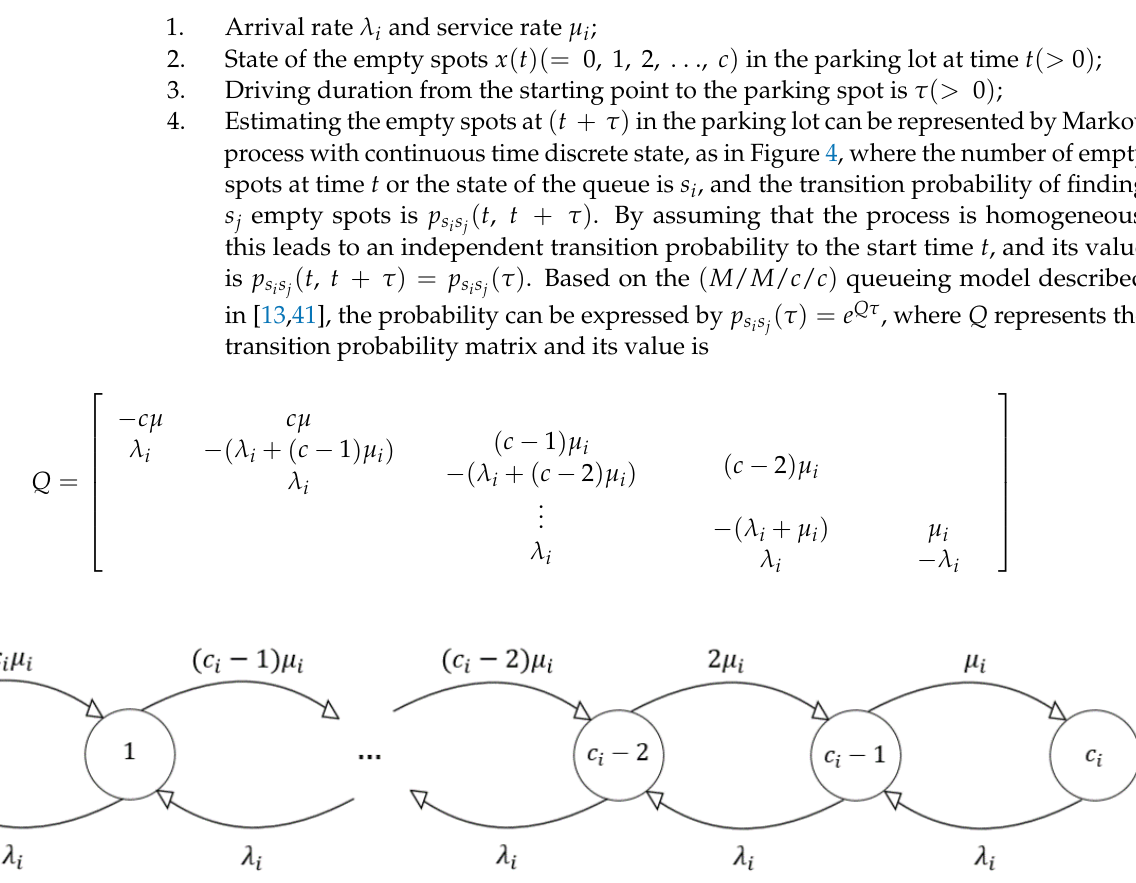
Figure 4. Markov model for parking lot P i with capacity c i